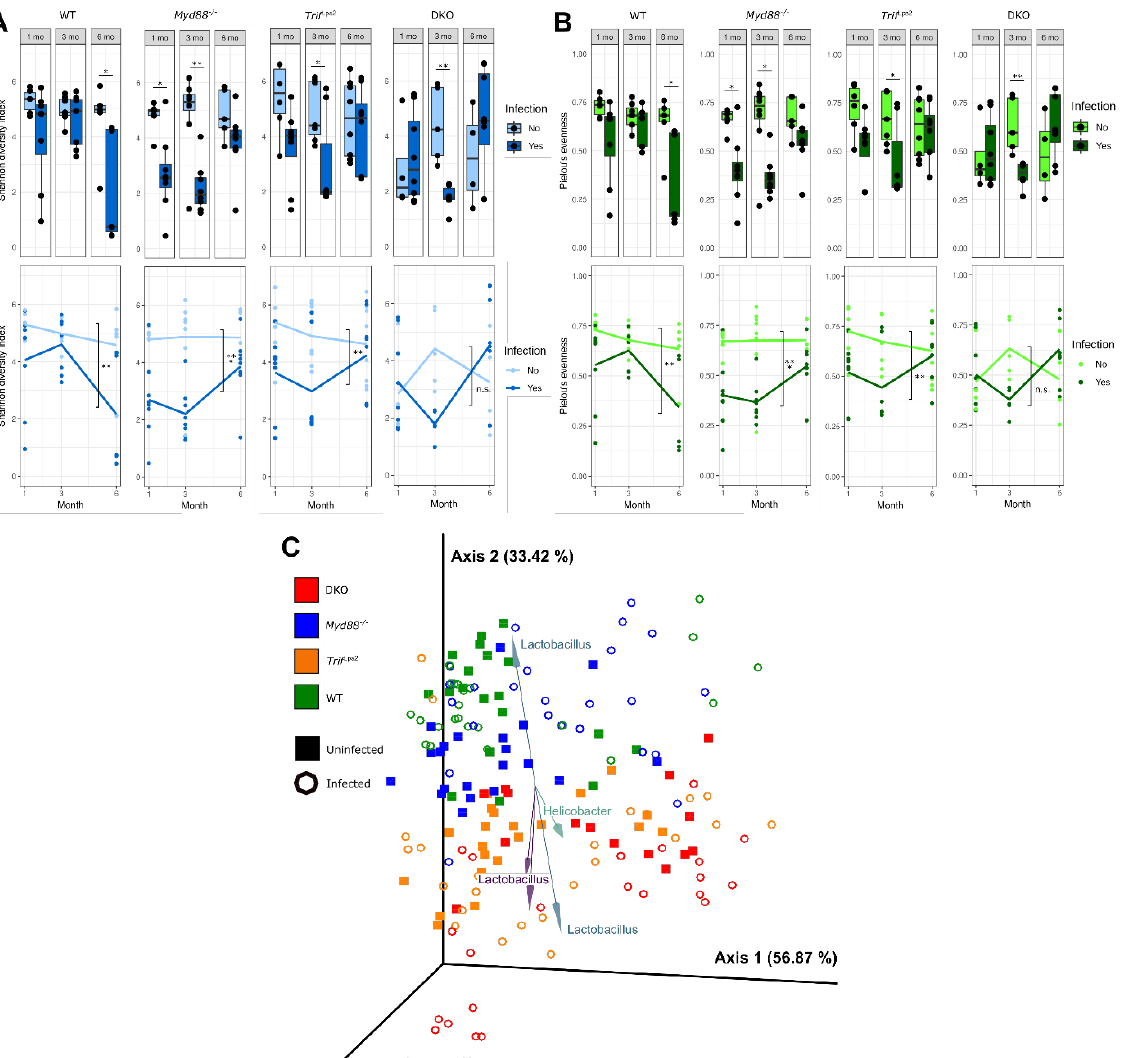
Figure 1. Changes in microbial diversity in the stomach across four different genotypes, with infection and time. Shannon diversity index ( A ) and Pielou’s evenness ( B ) values for each gastric community, divided by genotype and month. Top and bottom plots represent the same data, alpha diversity values, with lines on the bottom plots denoting average values for infected and uninfected communities over time. Statistical significance on bottom plots refers to differences between infected and uninfected, months 1 – 6 combined. ( C ) Principal component analysis of robust Aitchison distance values between communities, months 1 – 6 combined. Biplot arrows indicate operational taxonomic units (OTUs) driving separation between samples, with arrows labeled with the genus of the OTU. Arrows and genus labels are matched by color. All diversity metrics were calculated using QIIME2. Statistical significance determined by S tudent’s t -test for alpha diversity and permutational multivariate analysis of variance (PERMANOVA) with Benjamini-Hochberg FDR correction for beta diversity (* p < 0.05, ** p < 0.01, *** p < 0.005).